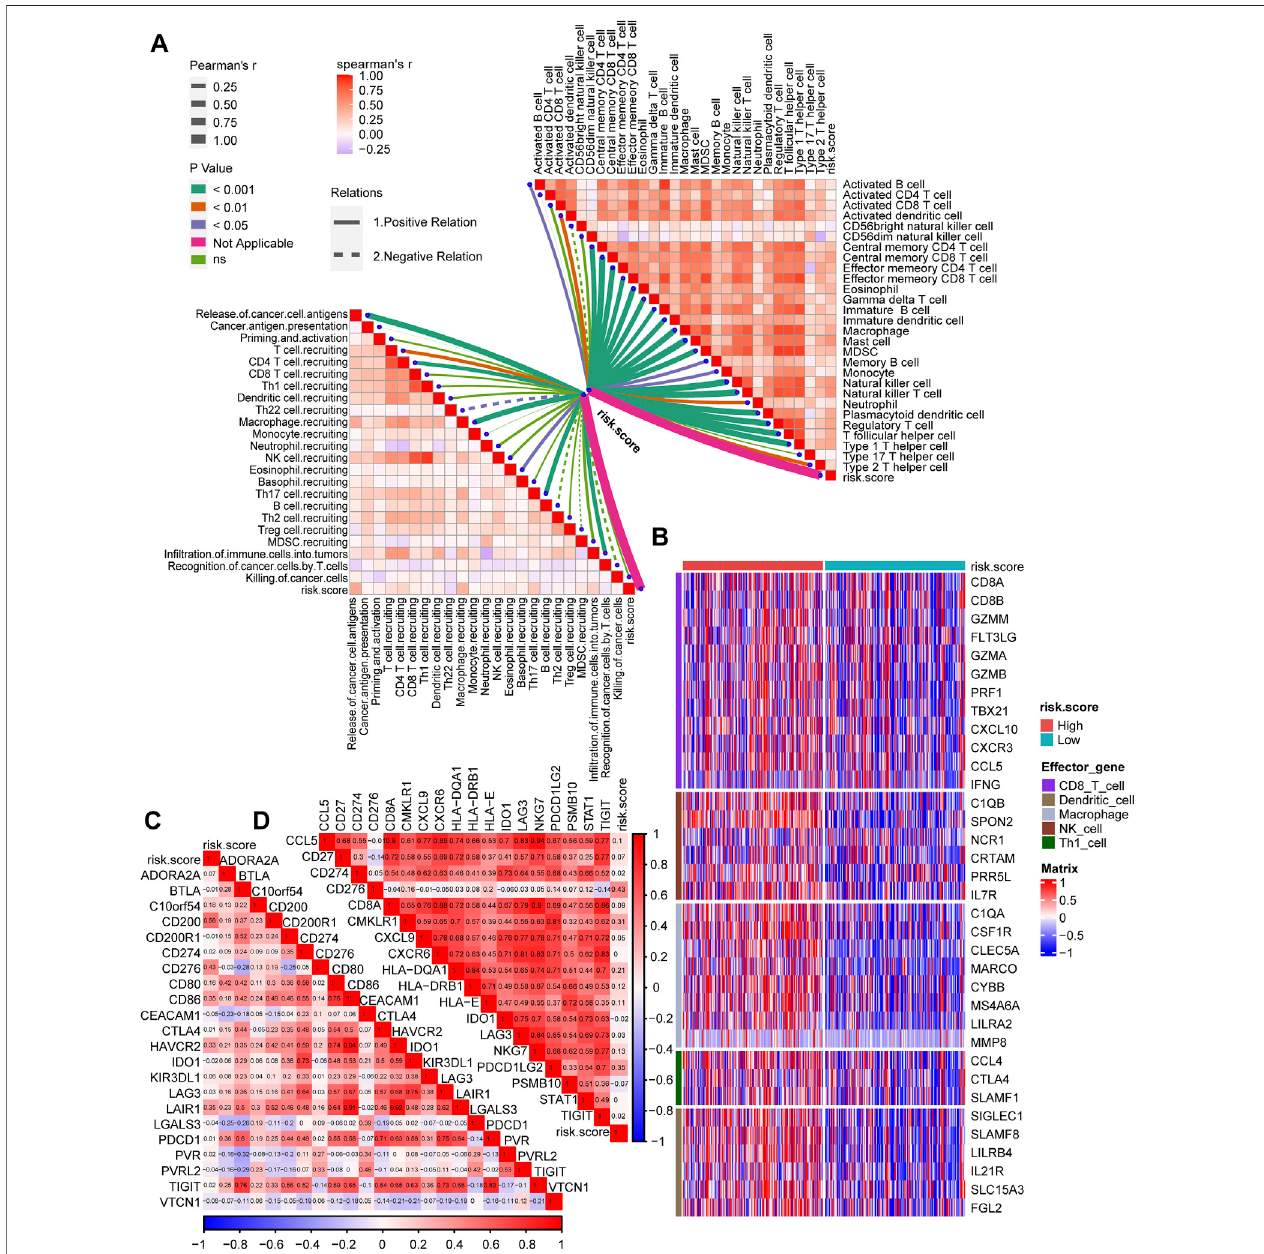
FIGURE 5 | The TGF β risk score correlated with the immune characteristics of the TME and predicted the clinical response to ICI treatment. (A) The correlations between the risk score and the cancer immunity cycles (left) or the in fi ltration of immune cells (right). (B) The differential expression patterns of effector genes in CD8 T cells, dendritic cells, macrophages, NK cells and Th1 cells between the high- and low-risk score groups. (C,D) The correlations between the risk score and immune checkpoint or the T cell in fl amed gene